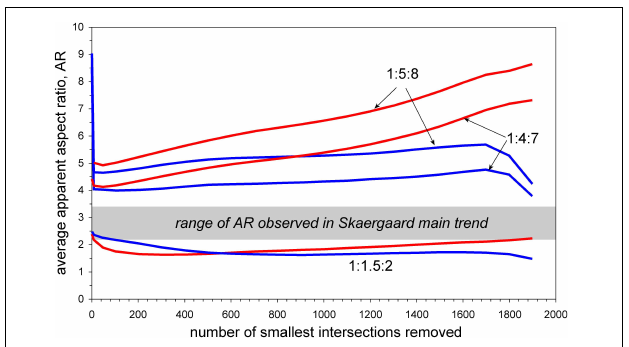
FIGURE 8 | The standard deviation of populations of plagioclase–plagioclase–plagioclase dihedral angles in the Skaergaard and Rum troctolites as a function of the difference, (cid:49) AR, between the observed AR and the expected AR were the sample to fall on the line of best fit through the main group of Skaergaard data (shown in Figure 5 ). Symbols as in Figure 5 . The horizontal gray boxes show the reported values of standard deviation for fully texturally equilibrated samples (from Vernon, 1968, 1970) and that consistent with random impingement of growing grains (from Elliott et al.,